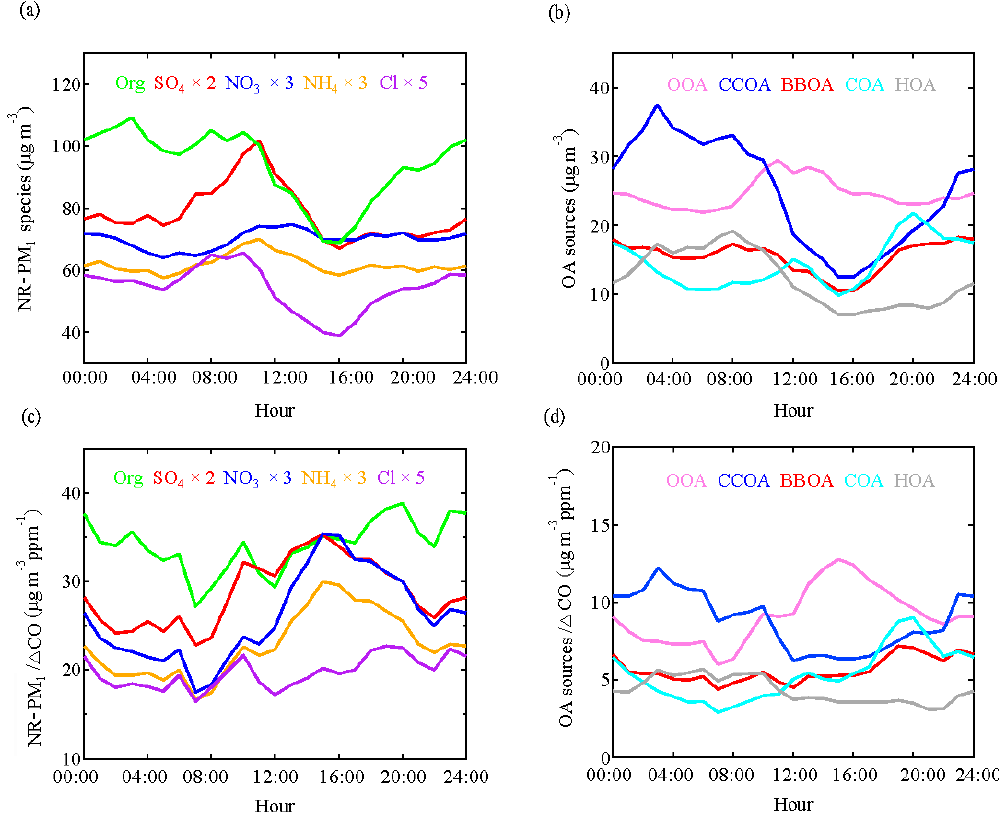
Figure 2. Diurnal variations of NR-PM 1 composition (a) , OA sources (b) , NR-PM 1 species /(cid:49) CO (c) , and OA sources /(cid:49) CO (d)